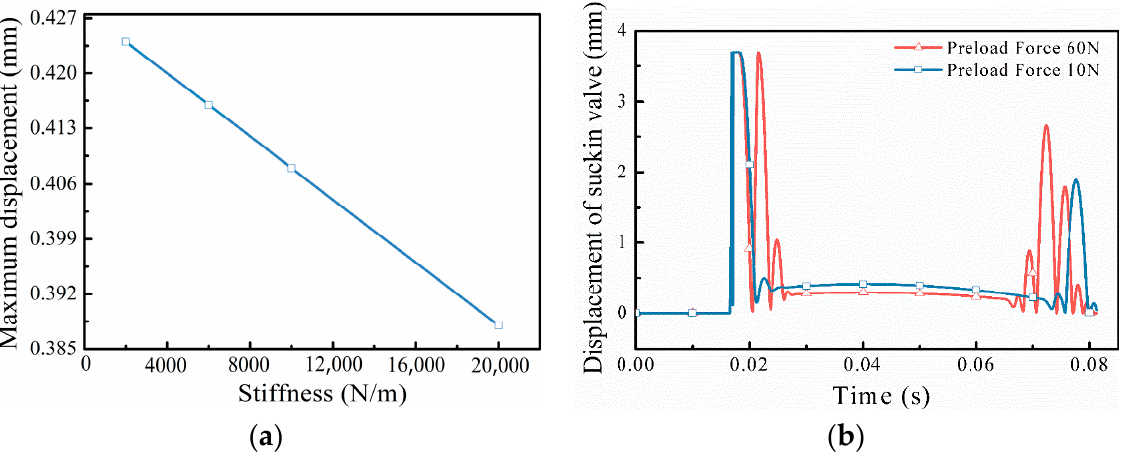
Figure 12. Effect of suction valve spring. ( a ) Effect of spring stiffness of suction valve on maximum spool displacement. ( b ) Effect of the preload force of the suction valve on the degree of spool oscillation.